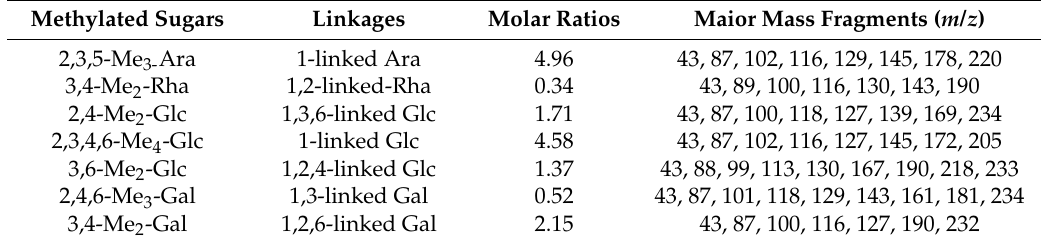
Table 2. Methylation results of